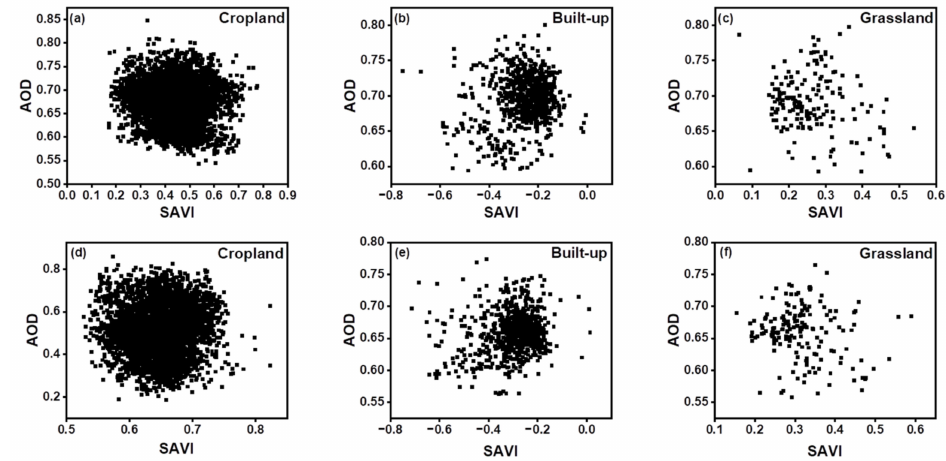
Figure 12. Scatterplot depicting the relationship between SAVI and AOD (Aqua ( a – c ), & Terra ( d – f )) values for different LULC